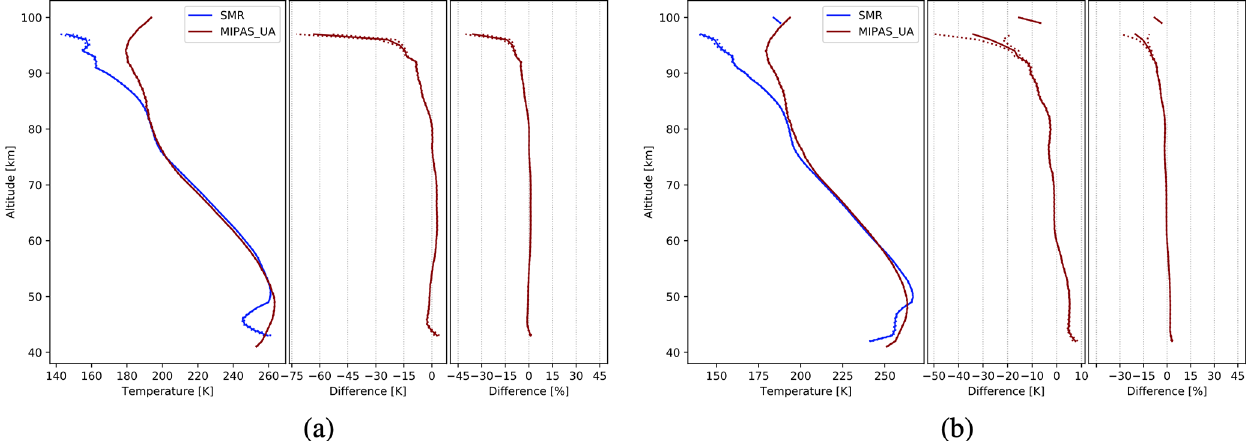
Figure A23. Comparison of SMR temperatures, from FM13 (a) and FM19 (b) , with those from MIPAS upper atmosphere mode retrievals. The data plotted are global averages over the whole time periods indicated in Table 2. Figure characteristics are the same as in Fig. 6.